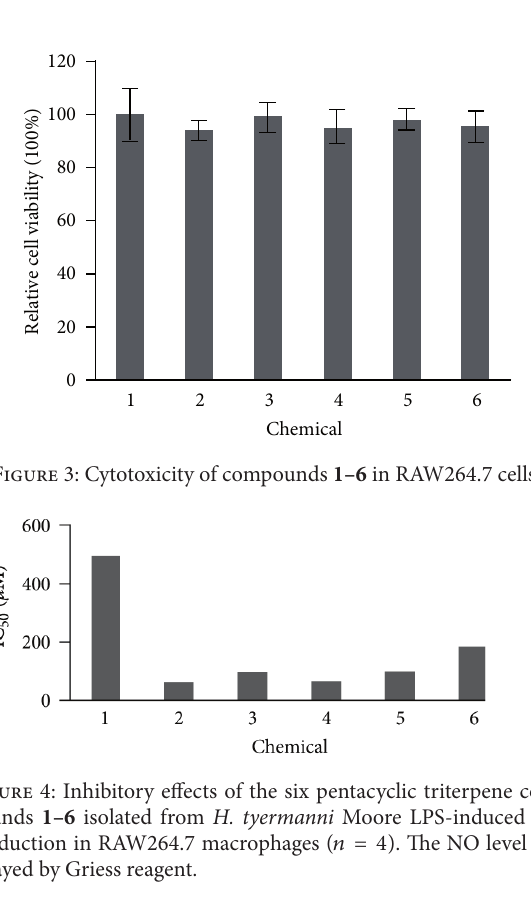
). e NO level was 𝑛𝑛 𝑛 𝑛